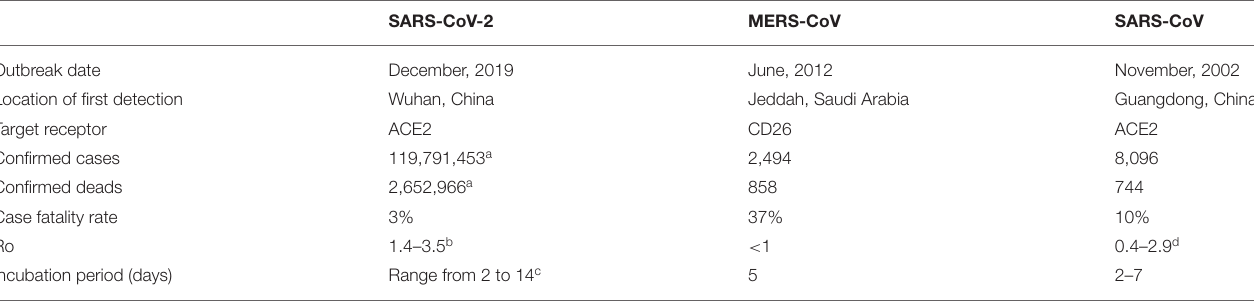
TABLE 1 | Characteristics of the three coronavirus outbreaks [information extracted from Wang et al. (7) from the study by Chen et al. study